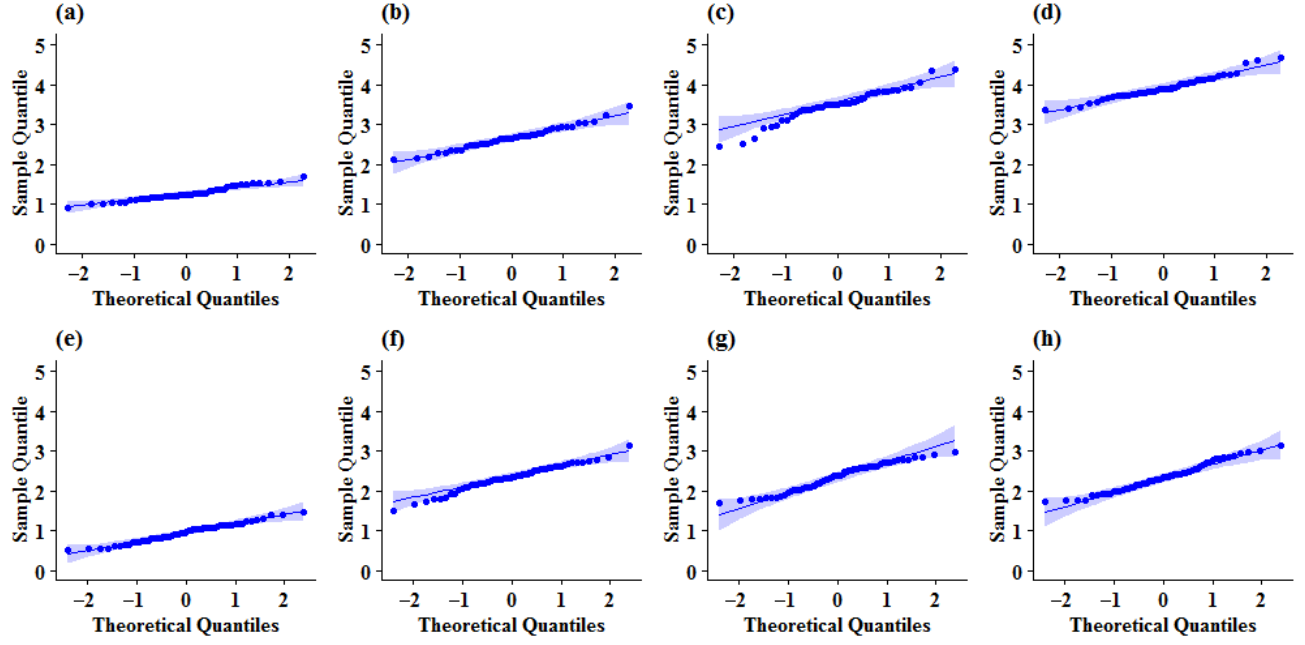
Figure 4. Q-Q results of experimental data. ( a ) Jointing, 2020; ( b ) 9th leaf, 2020; ( c ) Big trumpet, 2020; ( d ) Silking, 2020; ( e ) Jointing, 2021; ( f ) Big trumpet, 2021; ( g ) Silking, 2021; ( h ) Blister, 2021.